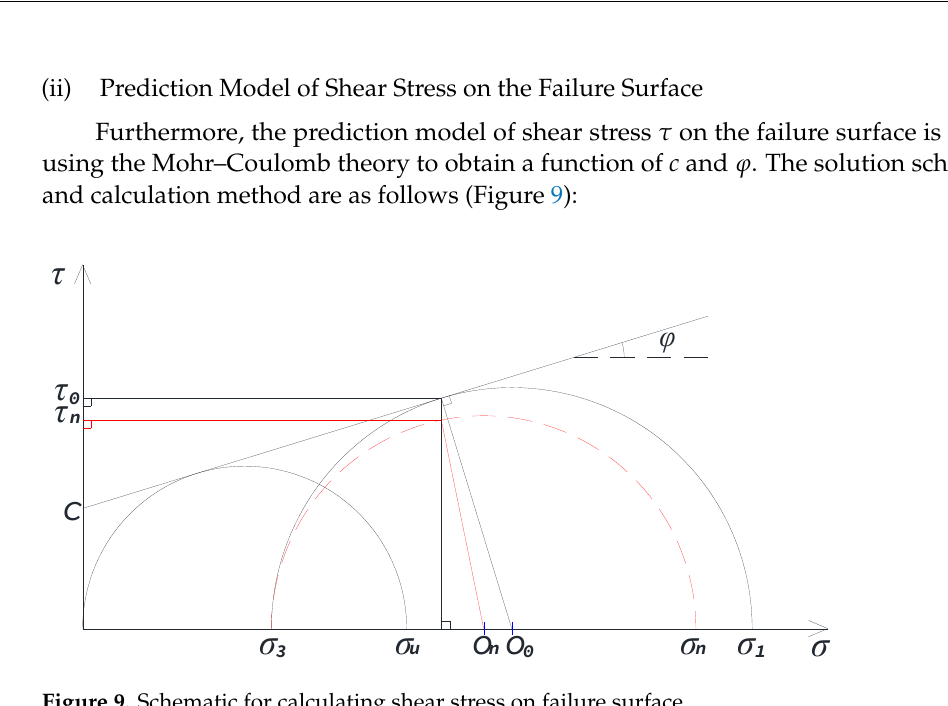
Figure 9. Schematic for calculating shear stress on failure surface.